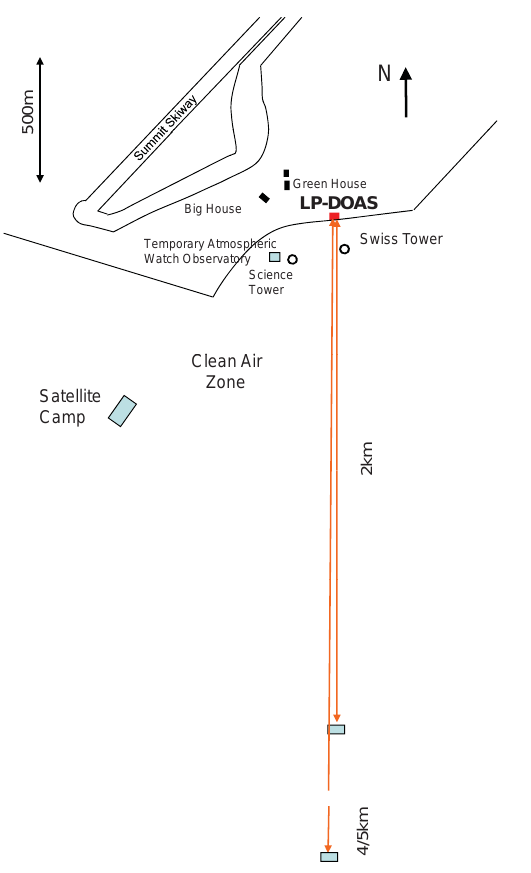
Fig. 1. Overview of the LP-DOAS setup during GSHOx.